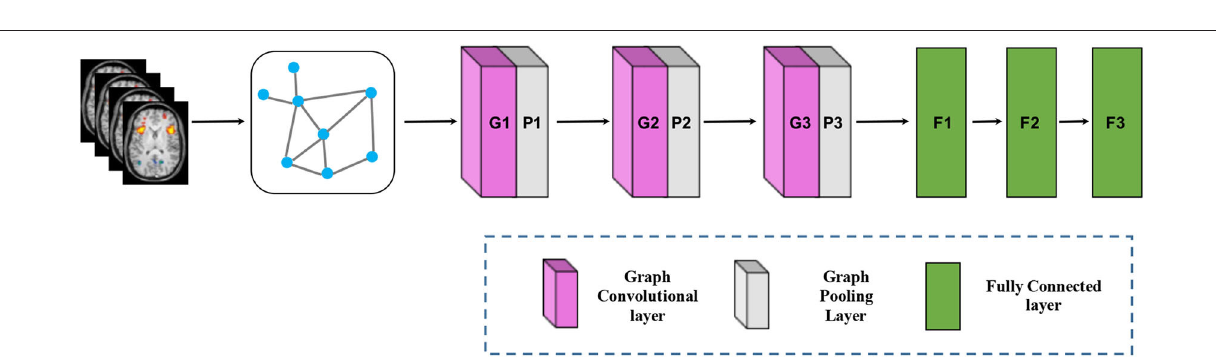
FIGURE 6 | Architecture of graph convolutional networks. To keep the figure simple, the softmax output layer is not